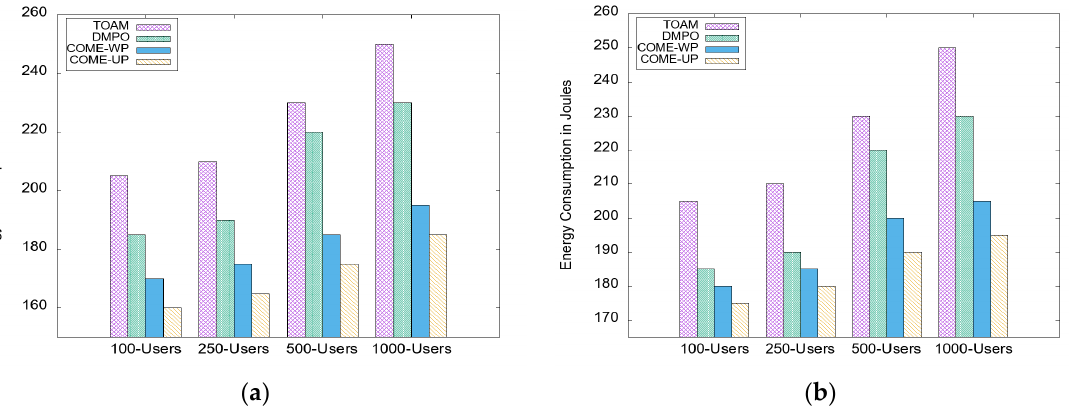
Figure 6. Energy consumption; ( a ) α = 0.25, β = 0.5 , Υ = 0.25; ( b ) α = 0.3, β = 0.3, Υ = 0.3.